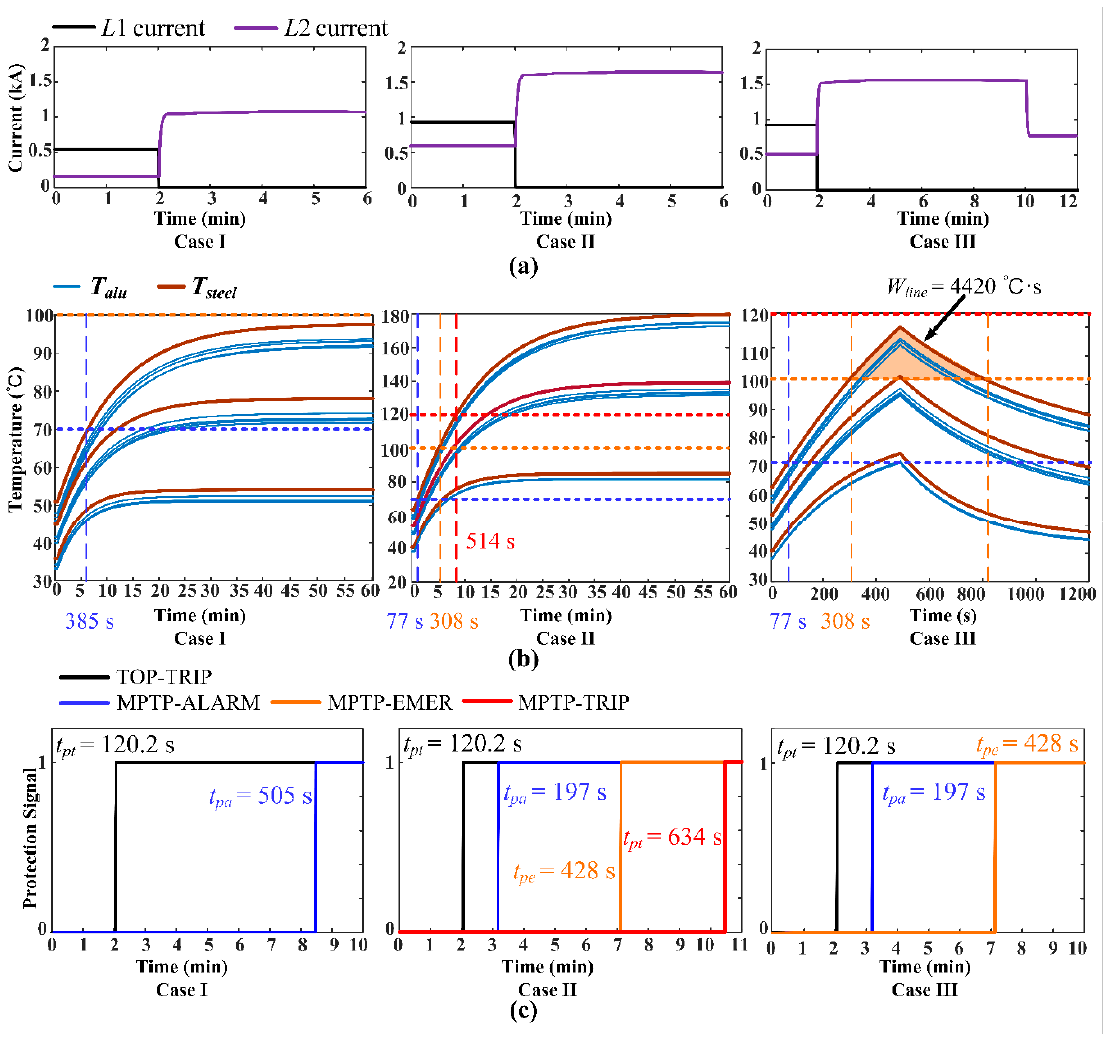
Figure 13. Simulation results of transmission line protection in three cases. ( a ) Current results; ( b ) temperature in different zones of the conductor cross-section; ( c ) Action signals of the MPTP and TOP.